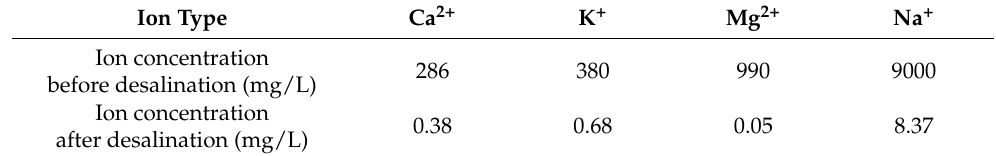
Table 1. Concentrations of Ca 2+ , K + , Mg 2+ , and Na + ions in solutions before and after desalination.